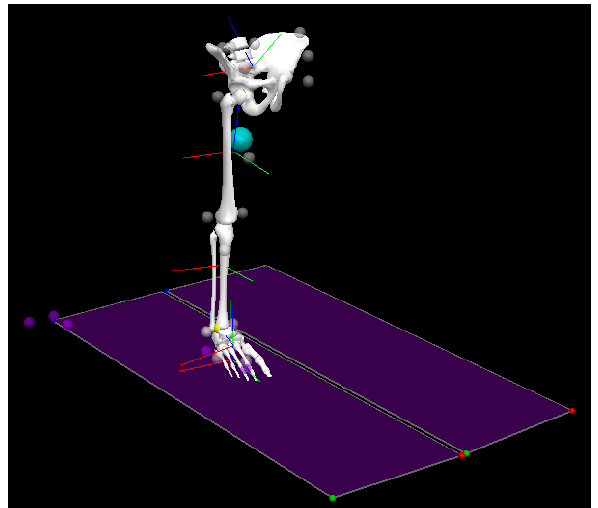
Figure 1. Attachment of markers on the lower extremity (the axis of angular displacement was defined as follows: red line: positive x-axis vector; green line: positive y-axis vector; blue line: positive z-axis vector; white circle: attachment of markers) by Visual 3D professional v6.03.4.